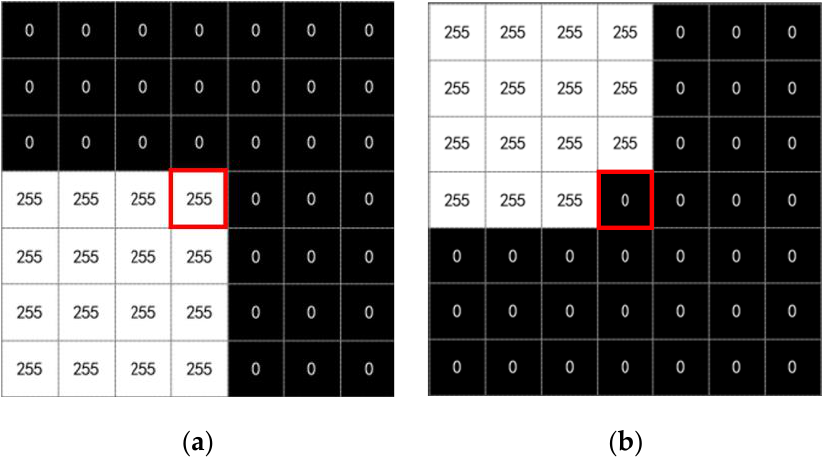
Figure 7. Bright point and dark point illustration. The red box indicates the detected keypoints ( a ) Bright point. ( b ) Dark point.